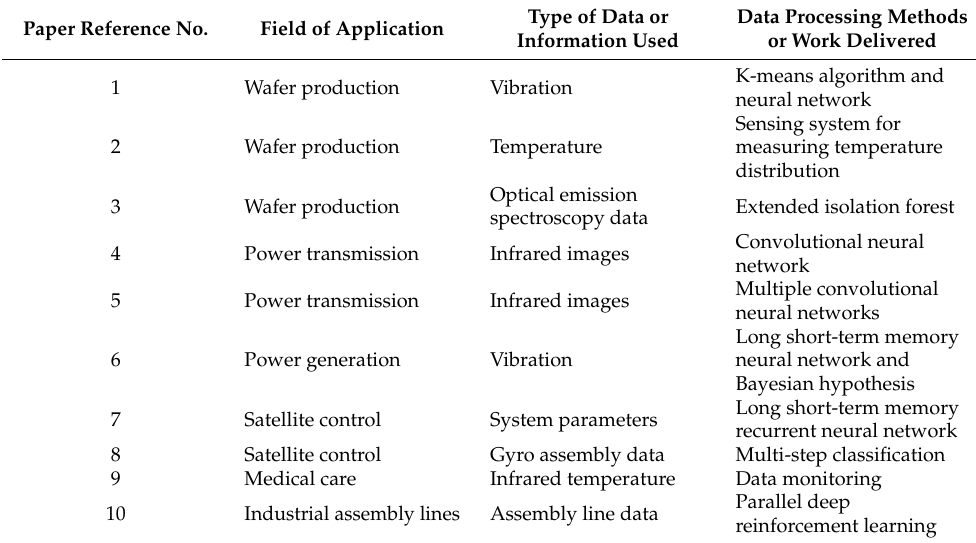
Table 1. Summary of the work reported in the ten papers. Paper Reference